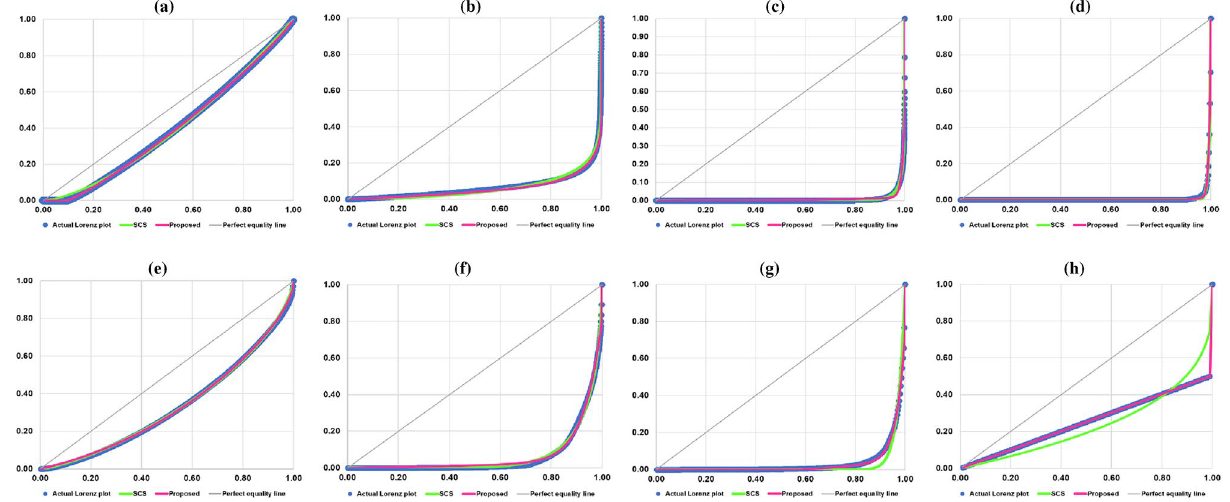
Figure 2. The actual Lorenz plots and the estimated Lorenz curves based on the proposed model and the SCS model. ( a ) Earthquake intensity. ( b ) Solar flare intensity. ( c ) Mammal body mass. ( d ) Metabolic degree.